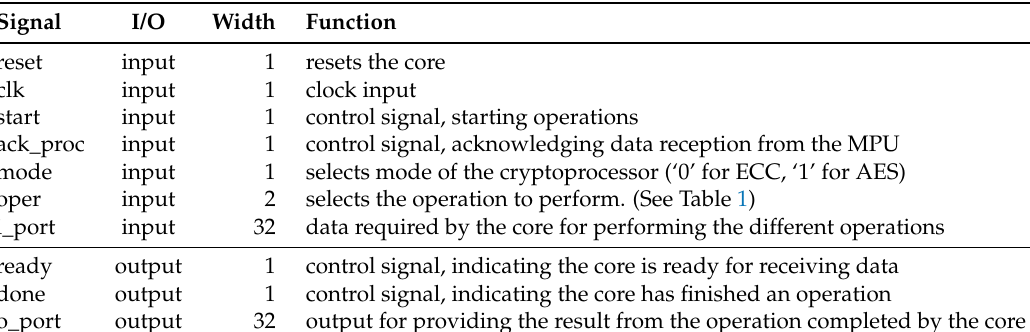
Figure 2. ECC163AES128 pinout. Table 2. ECC163AES128 pin